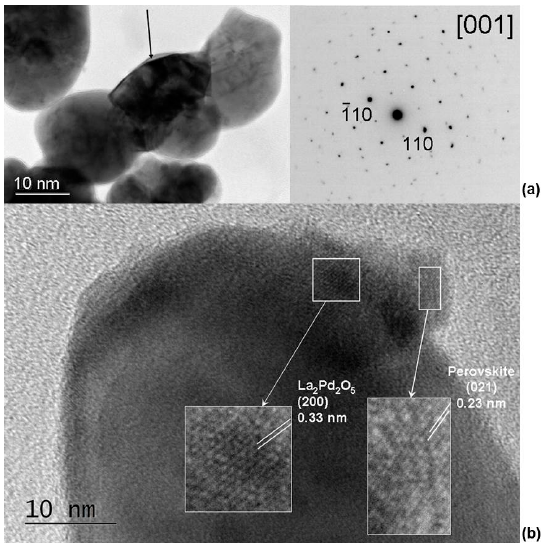
Figure 2. Bright field images and SAED ( a ), HRTEM ( b ) of Pd-LMO/Imp.